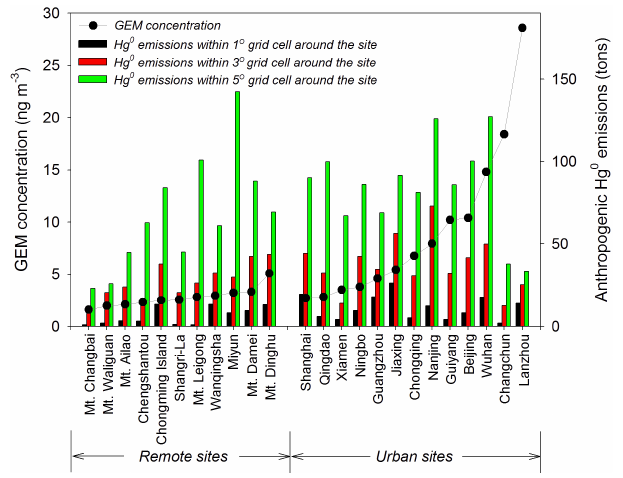
Figure 2. Atmospheric GEM concentrations and total anthro- pogenic Hg 0 emissions within the 1 ◦ × 1 ◦ , 3 ◦ × 3 ◦ , and 5 ◦ × 5 ◦ grid cells surrounding the ground-based sites in mainland China.